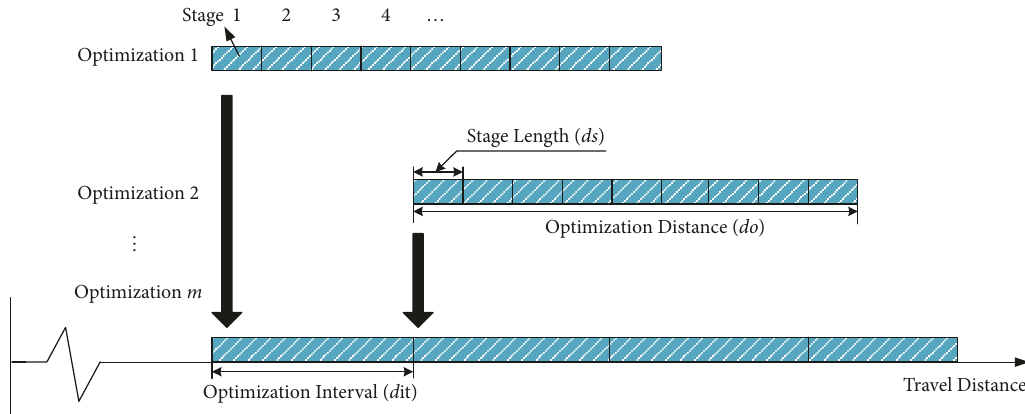
Figure 1: Rolling horizon optimization logic